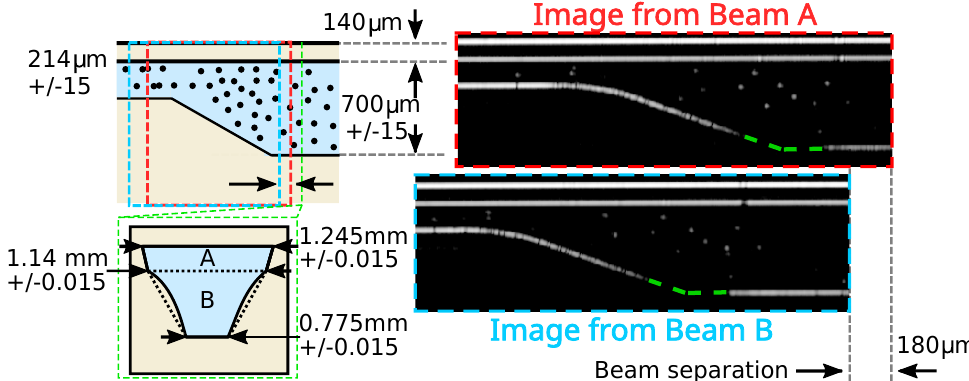
Figure 3. Schematic of the sloped section of the microfluidic chip with the area imaged by Beams A and B of the dual beam OCT instrument marked with blue and red outlines. The actual OCT images are shown with matching outline colours. The superimposed green dashed line marks the location of the slope. The spanwise width cross-section of the microfluidic channel is shown in the lower left outlined in green, including the PMMA slumping around the base of the